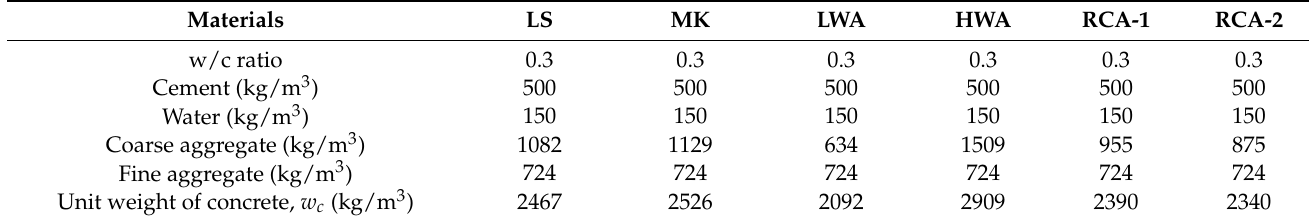
Table 3. Concrete mixture design of Mix